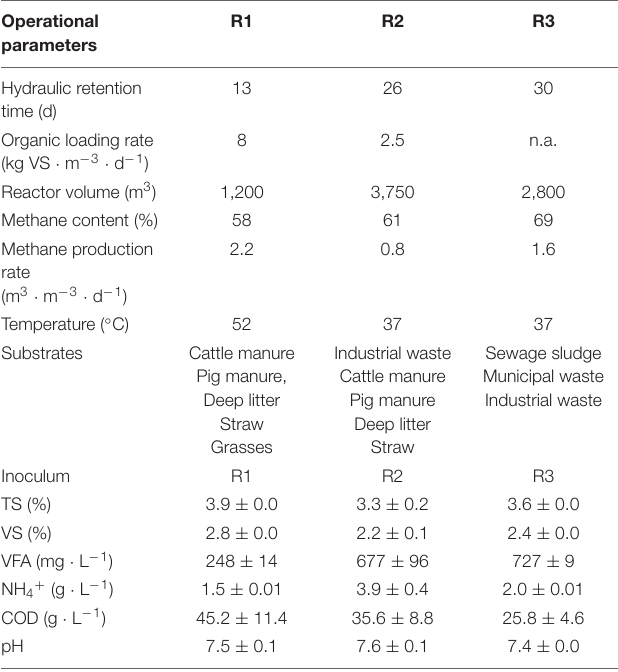
TABLE 1 | Operational information of the sampled full-scale digesters and the physiochemical characteristics of the biomass samples used as inoculum in the lab-scale